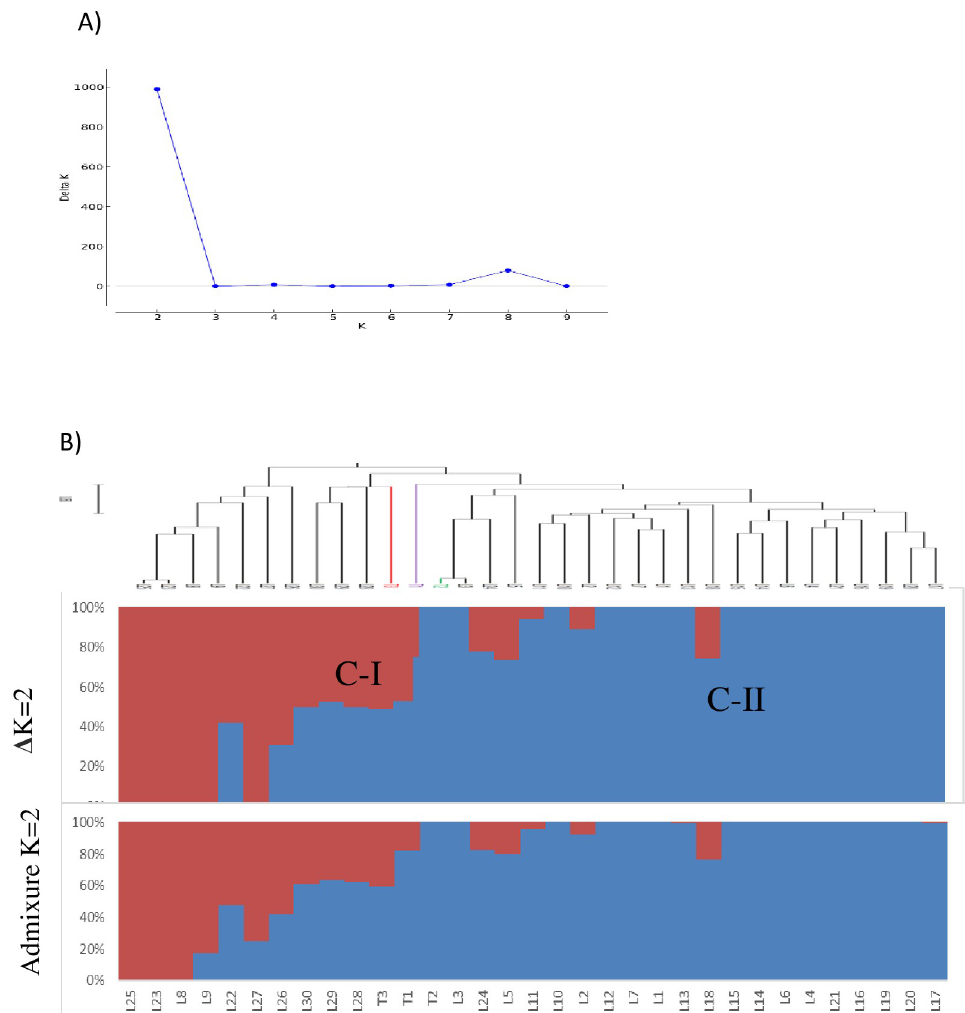
Fig 4. Population structure of the 30 yellow endosperm maize inbred lines and three testers with varying levels of resistant to Striga .